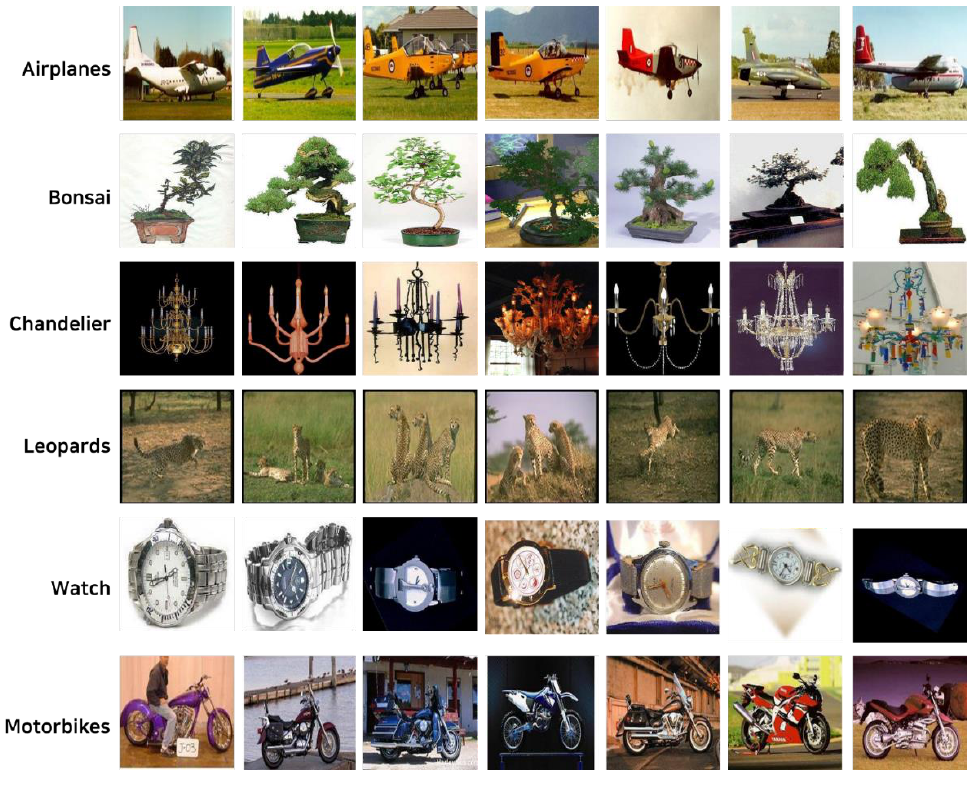
Figure 5. Caltech 101 data set. Table 3. Configuration of Caltech 101 data